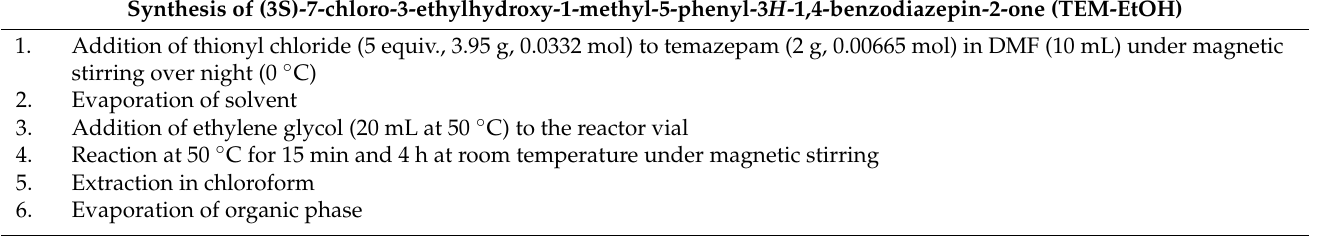
Table 2. Summary of the reaction sequence for FETEM precursor